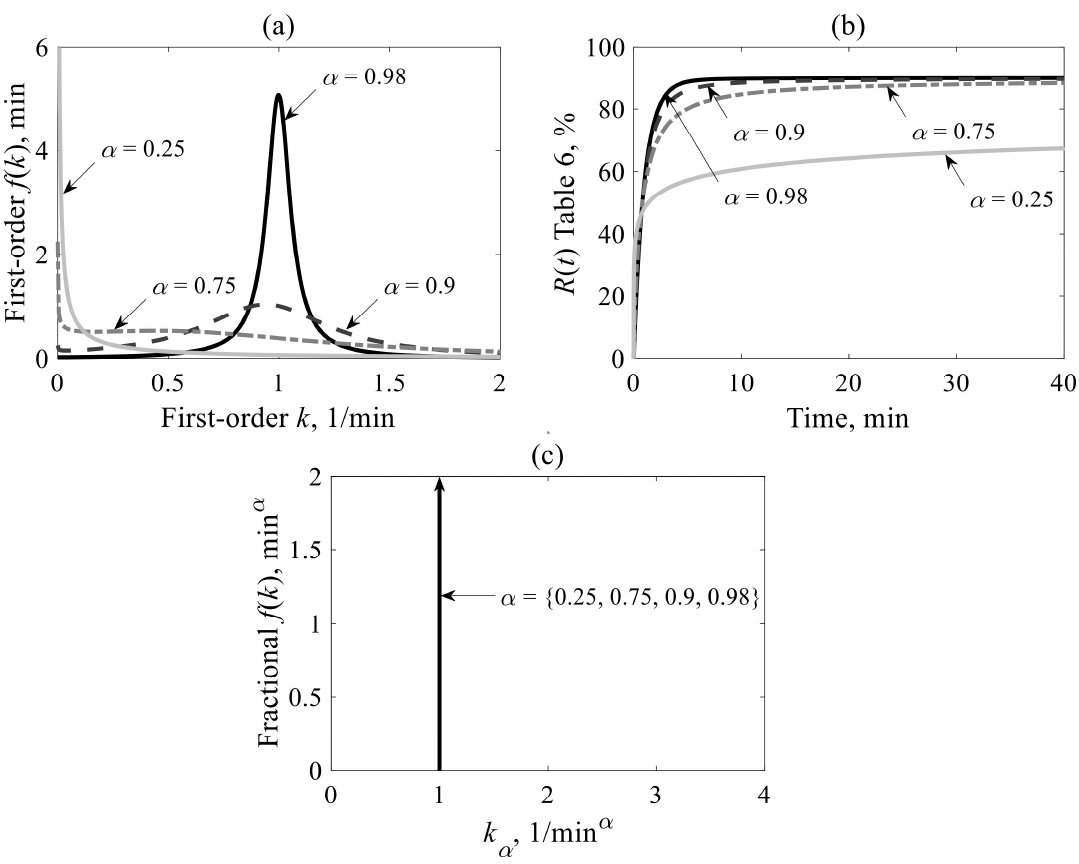
Figure 8. Examples of estimated f ( k )s and model fitting, size-by-size Cu results; ( a ) First-order f ( k )s, Equation (14), ( b ) Time-recovery data, continuous curves obtained by fitting the R ( t ) model of Table 6, ( c ) Fractional f ( k )s. 4. Discussion Several model structures for R ( t ) have been proposed in literature as alternatives to the first- order reactions in batch flotation (e.g., nth-order reactions with continuous or discrete f ( k ), Rosin– Rammler R ( t ), Fractional kinetics). The results of Figures 1–8 showed that the four evaluated models